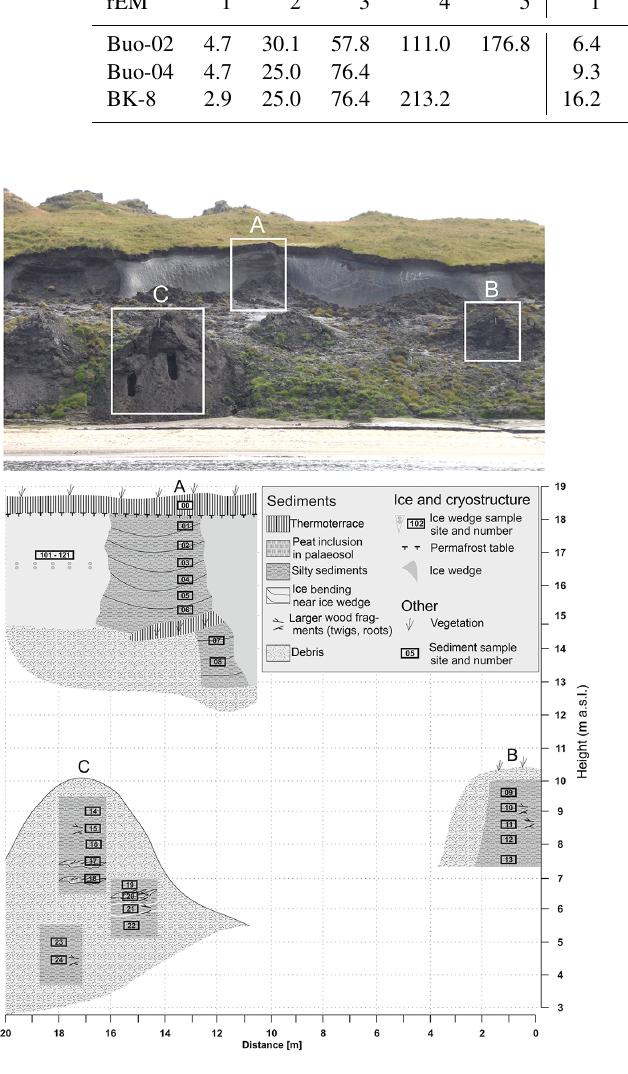
Figure 5. Overview photo and scheme of the Buo-04 Yedoma IC exposure with sample positions and main cryolithological features (modified from Strauss and Schirrmeister,